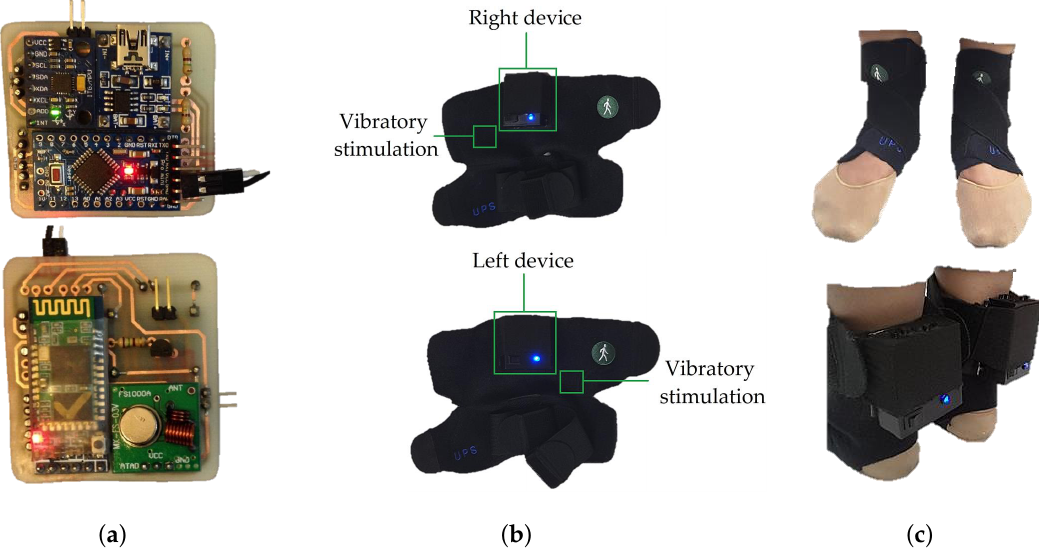
Figure 4. ( a ) Printed Circuit Board with components; ( b ) Encapsulated device in ergonomic support; ( c ) Device placed in